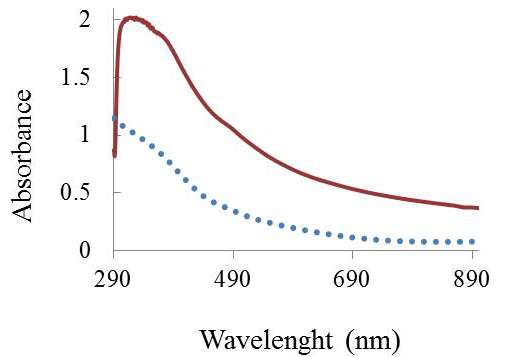
O nanoparticles 3 4